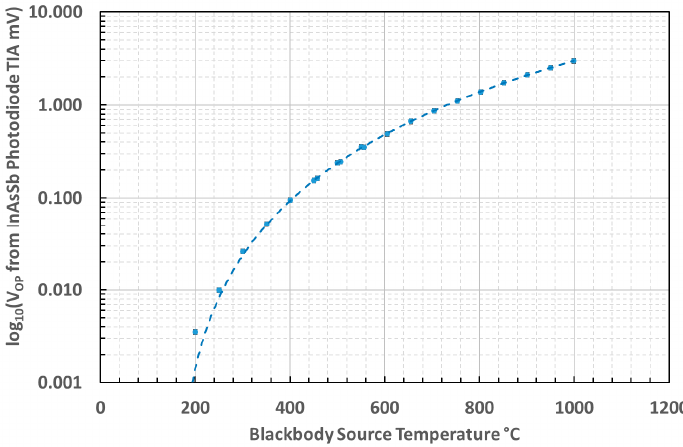
Figure 5. Output voltage of the infrared thermometer as a function of source temperature.